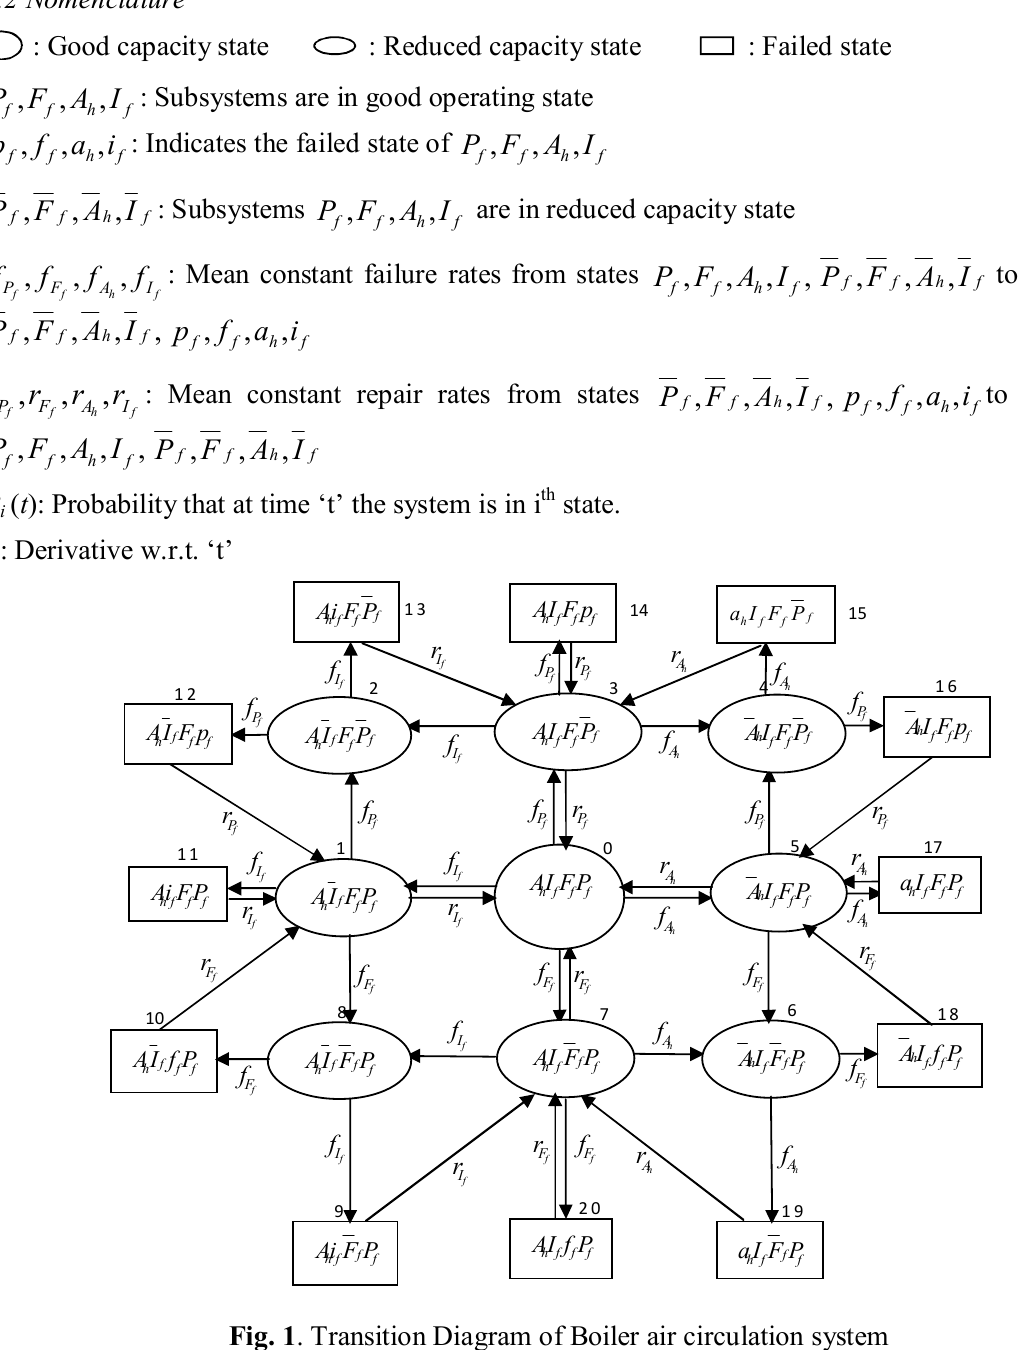
Fig. 1 . Transition Diagram of Boiler air circulation